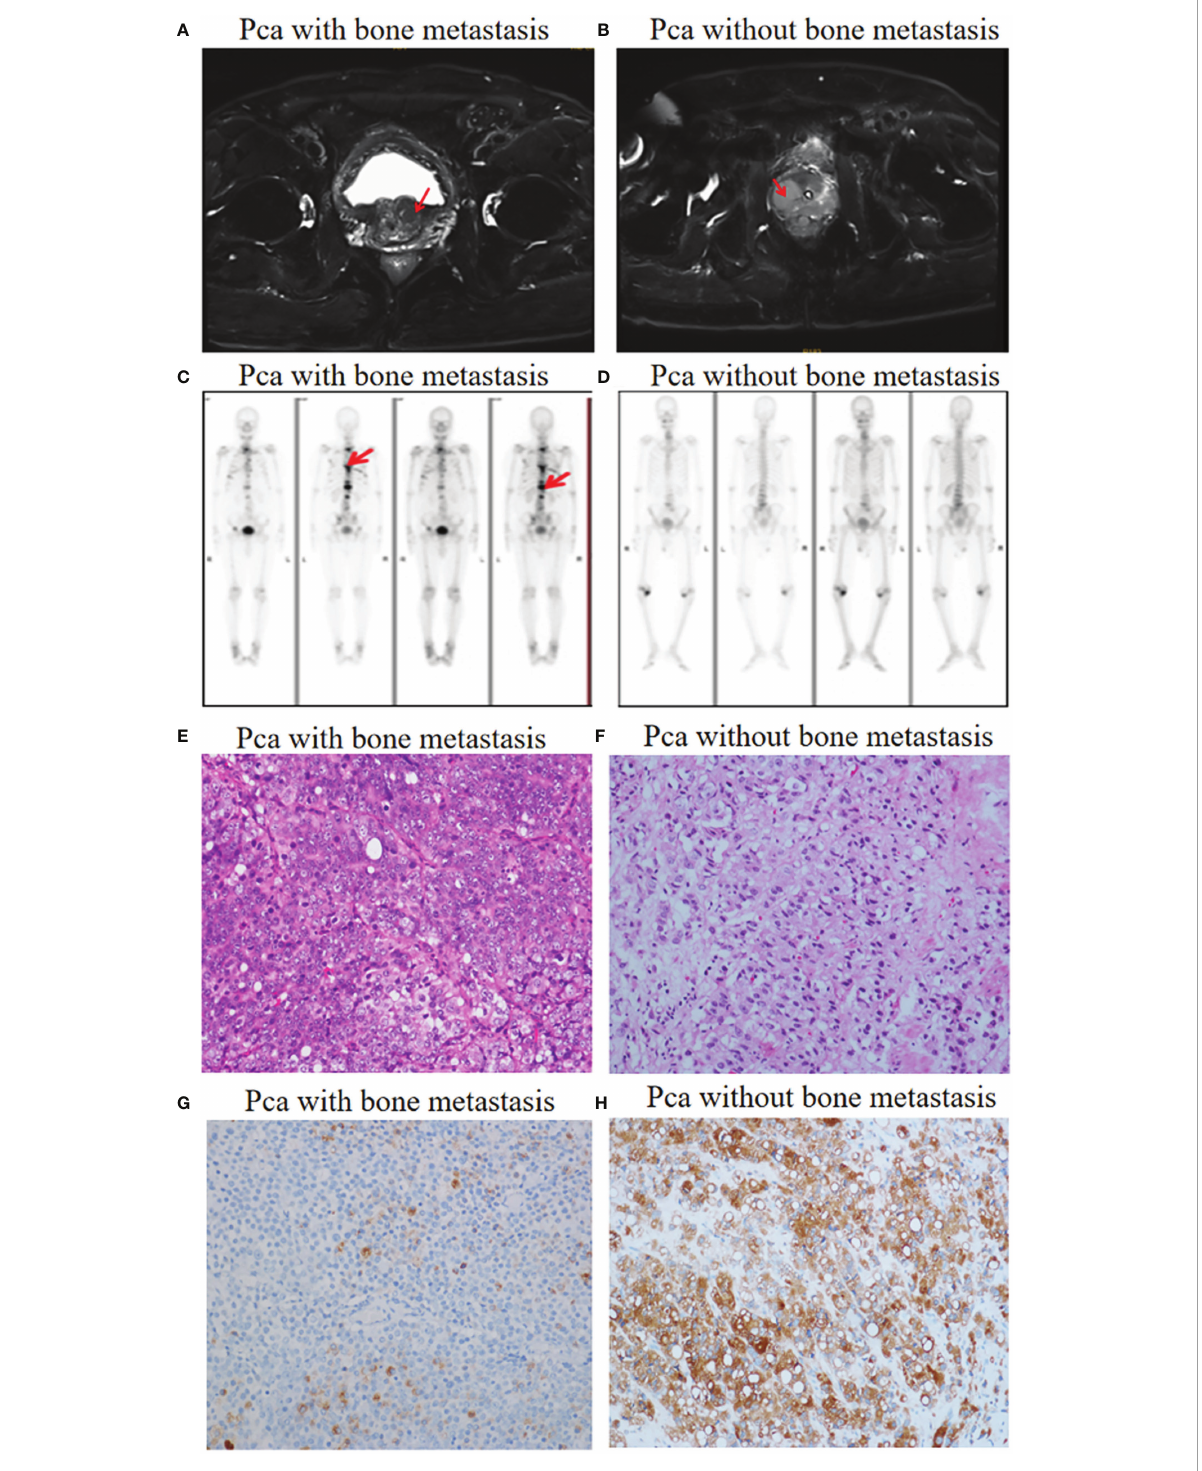
FIGURE 1 Pca with and without bone metastasis: diagnosis. (A) Pelvic MRI allowed visualization of a tumor in the prostate left lobe (red arrow). No metastases were found. (B) A tumor in the prostate right lobe with bone metastases (red arrow). (C) Whole body bone scanning showed Pca with bone metastases (red arrow). (D) Whole body bone scanning showed Pca without bone metastases. (E, F) HE staining images (objective 20X) showing prostate cancer morphology in the presence and absence of bone metastases. (G, H) Prostate-speci fi c antigen (PSA) staining images (objective 20X) showing prostate cancer cells with fl aky distribution in the presence and absence of bone